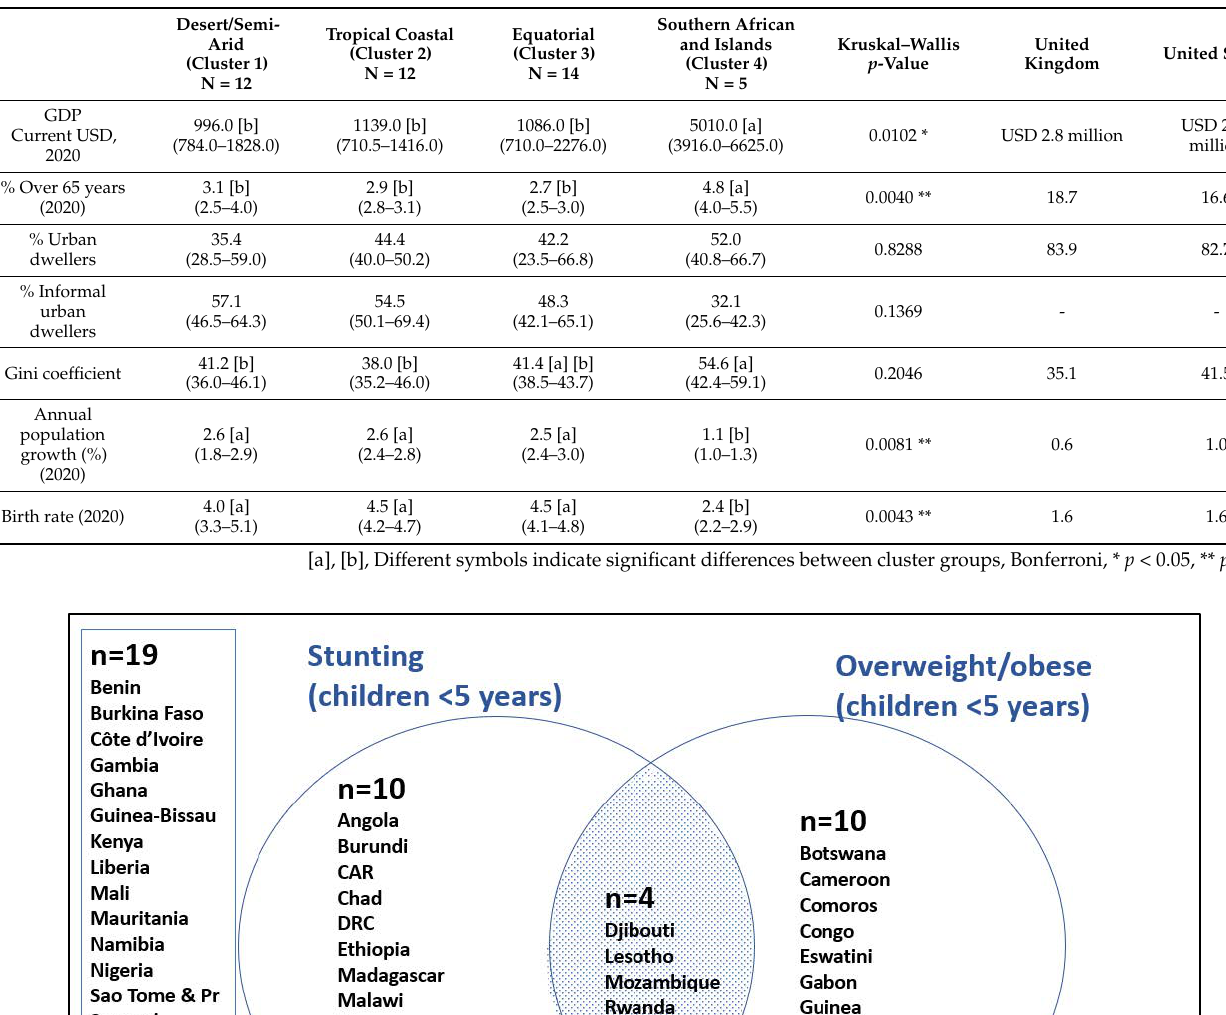
Table 6. Median and interquartile range values of some socioeconomic and demographic statistics for the four clusters.